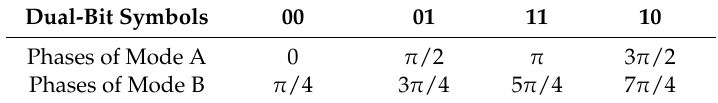
Table 2. Coded relationship between the input dual-bit symbols and the modulated phases.